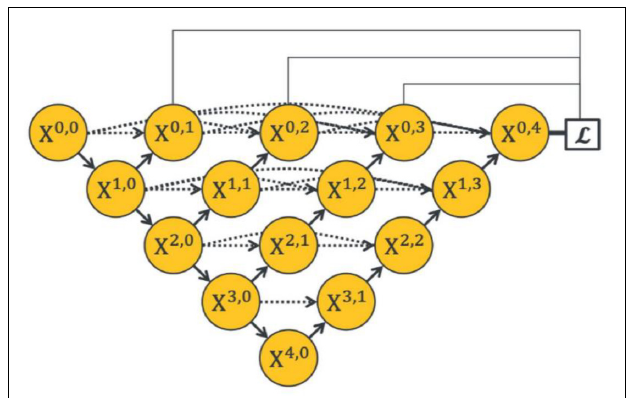
FIGURE 4 | Architecture of the UNet++ by Zhou et al. (2018).